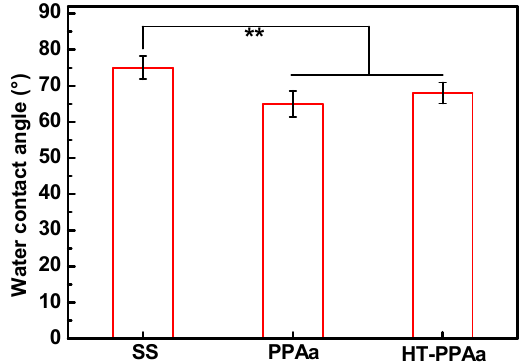
Figure 3. The water contact angle of stainless steel (SS), PPAa, and HT-PPAa film. Data are presented as mean ± SD ( n = 4) and analyzed using one-way ANOVA (* p < 0.05, ** p < 0.01, and *** p < 0.001).